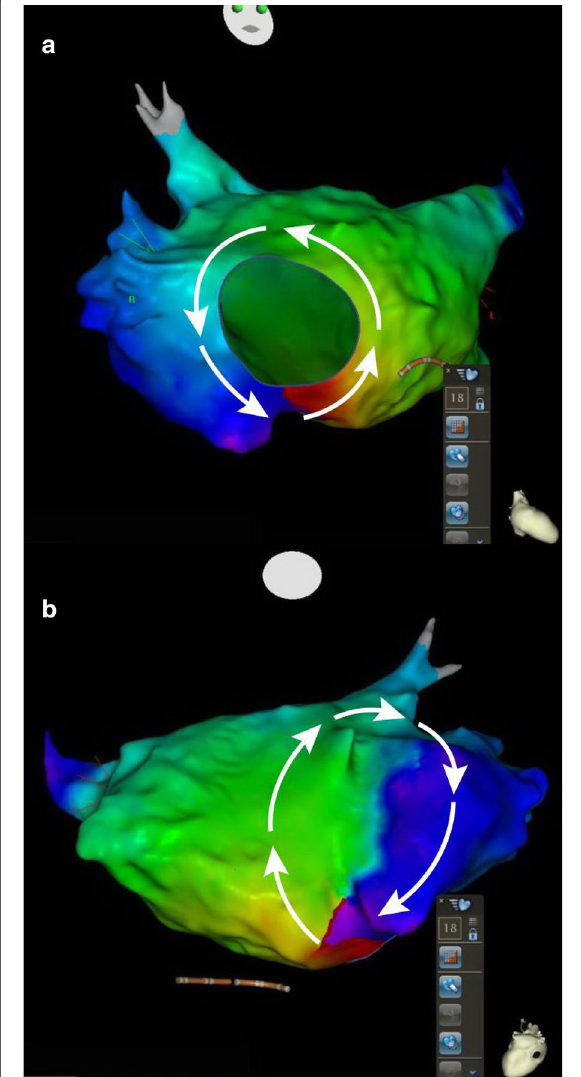
Fig. 2 High-density mapping and entrainment of LA. a High-density mapping of the LA showing the major tachycardia circuit located around the anatomic tricuspid annulus (functional mitral annulus). b Second tachycardia circuit located in local area behind aberrant left atrial